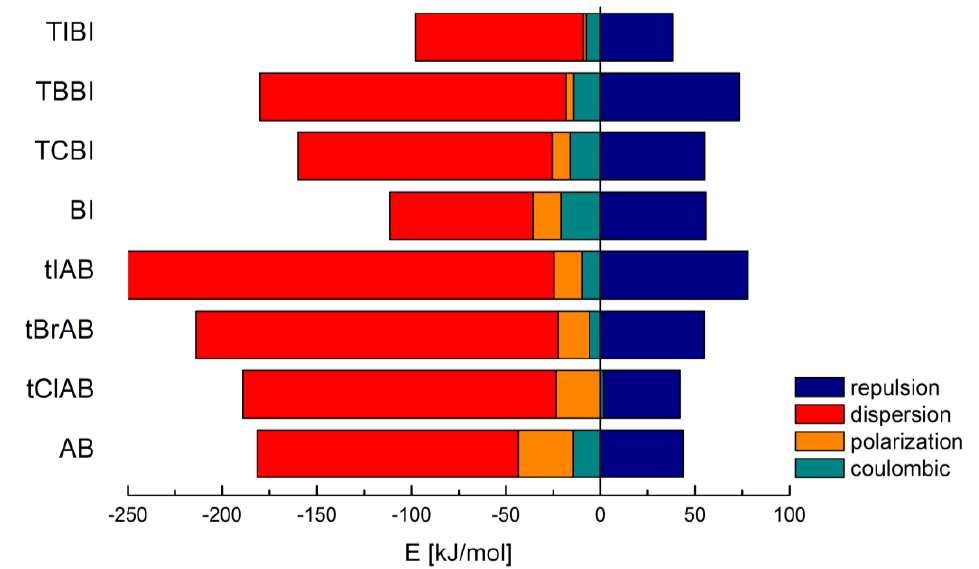
Figure 3. Contributions to the total lattice energy broken down into a few different basic interaction types in adamantylated 4,5,6,7-tetrahalogeno-1 H -benzimidazoles, 1 H -benzimidazole (BI) and 4,5,6,7-tetrahalogeno-1 H -benzimidazoles (TIBI, TBBI, TCBI).